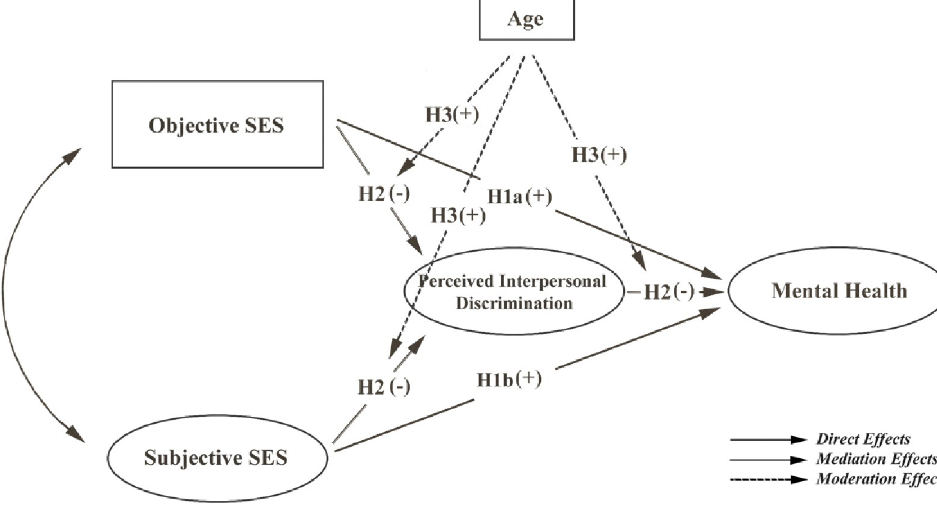
Fig 1. Conceptual framework. Note. SES: Socioeconomic status; H1a (+): Hypothesis 1a, which is expected to be positive.